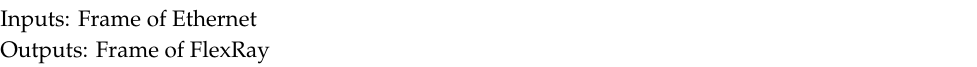
Figure 4. Ethernet frame transformed to FlexRay frame. Algorithm 2. Data path from Ethernet to